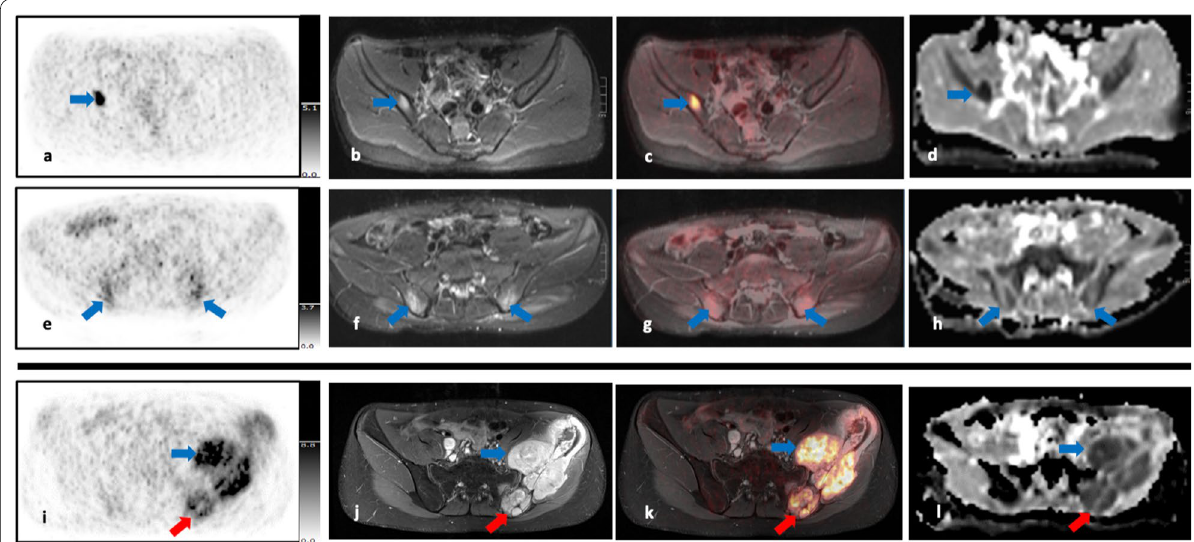
Fig. 8 a–l Images from the upper and the middle row belong to the same patient, whereas images from the lower row belong to another patient. The upper row ( a–d ) shows images of a single lesion in the middle of the right iliac bone (blue arrow). The lesion has increased glucose metabolism on [ 18 F]‑FDG‑PET images (SUV max 9.80) ( a, c ), is hyperintense on MR T2‑TIRM images ( b ) and has restricted diffusion on DWI (ADC about 419 mm 2 /s) ( d ). The middle row ( e–f ) shows images including the biopsy sites on both posterior iliac crests (blue arrows): Both biopsy sites have moderate and diffuse radiotracer uptake on [ 18 F]‑FDG‑PET images (SUV max right: 2.65; SUV max left: 2.74) ( e,g ), are moderately hyperintense on MR T2‑TIRM images ( f ) and do not show restriction in diffusion on DWI (ADC right: about 1240 The third row shows extensive lymphoma involvement of the left iliac bone and the biopsy channel ( i‑l ): Lymphoma manifestation from the left iliac bone have markedly increased glucose metabolism on [ 18 F]‑FDG‑PET images (blue arrows) ( i, k ), are hyperintense on MR T2‑TIRM images ( j ) and markedly restricted in diffusion on DWI ( l ). The biopsy channel (red arrows) can be distinguished from the lymphoma lesions by lack of radiotracer uptake ( i, k ). It is hypointense on MR T2‑TIRM images ( j ) and shows no diffusion restriction on DWI ( l